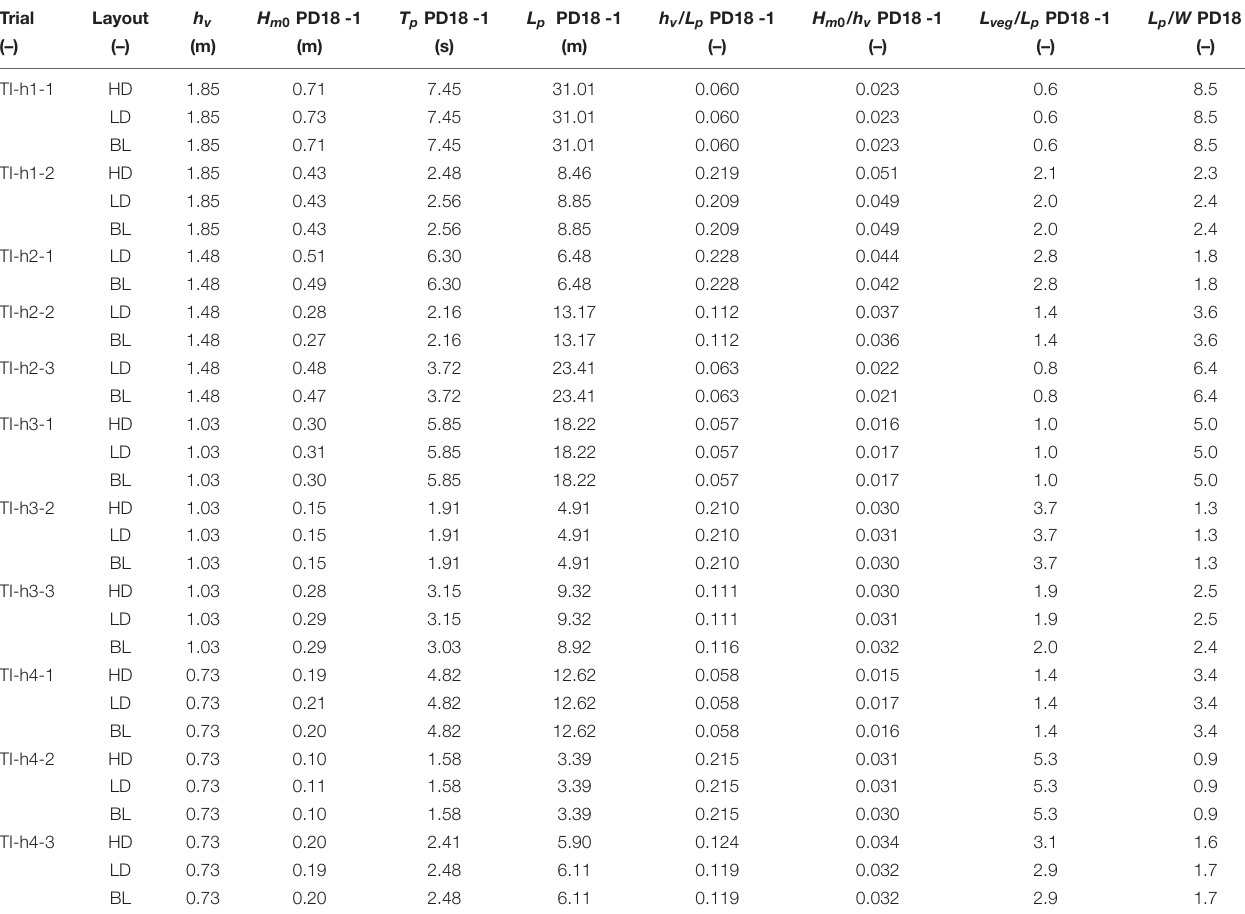
TABLE 1 | Measured wave conditions at test section for random wave trials.